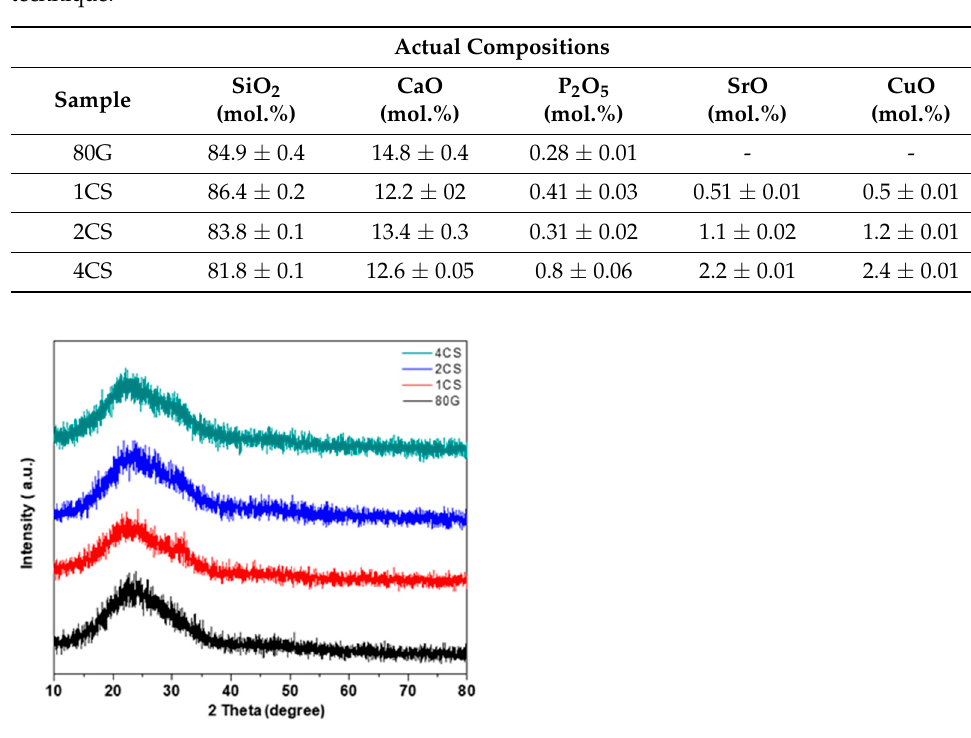
Table 1. Represents the composition of prepared MBG powders determined by the ICP-OES technique.